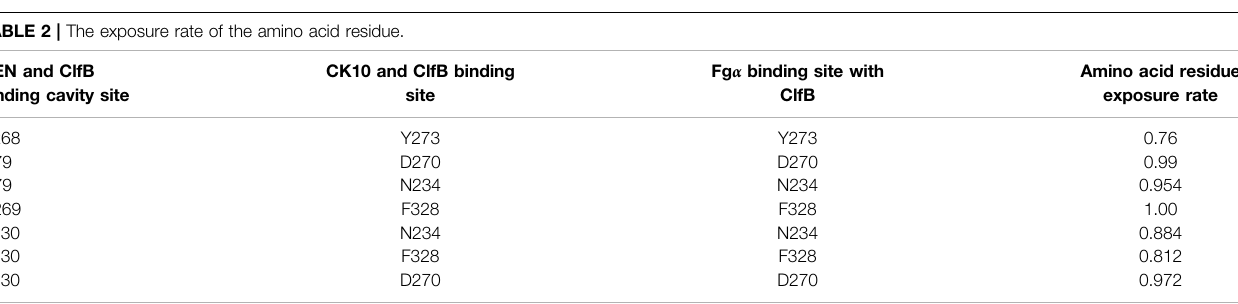
TABLE 2 | The exposure rate of the amino acid